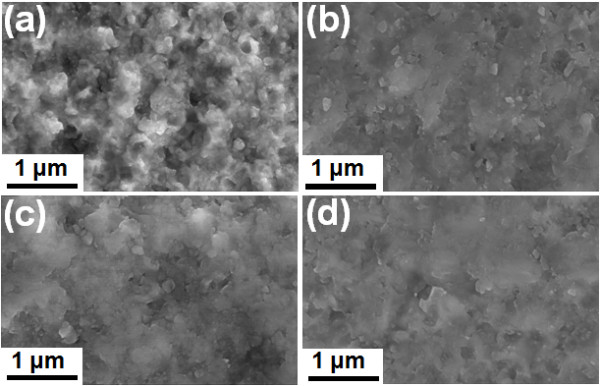
Surface SEM micrographs. Surface SEM micrographs of 0.2-μm-thick BaTiO3 thin film on (a) Cu and (b) SUS substrates and 2-μm-thick BaTiO3 thick films on (c) Cu and (d) SUS substrates.